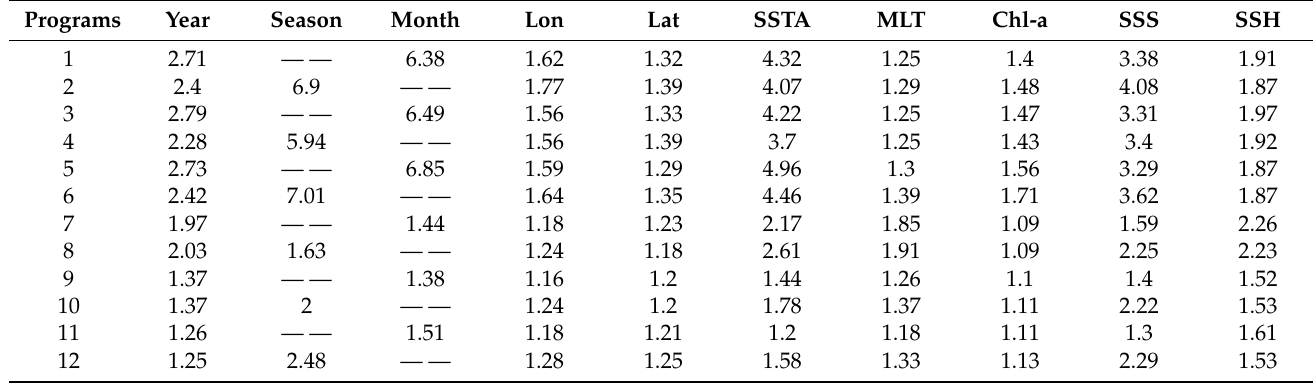
Table 2. VIF test results for each explanatory variable at different